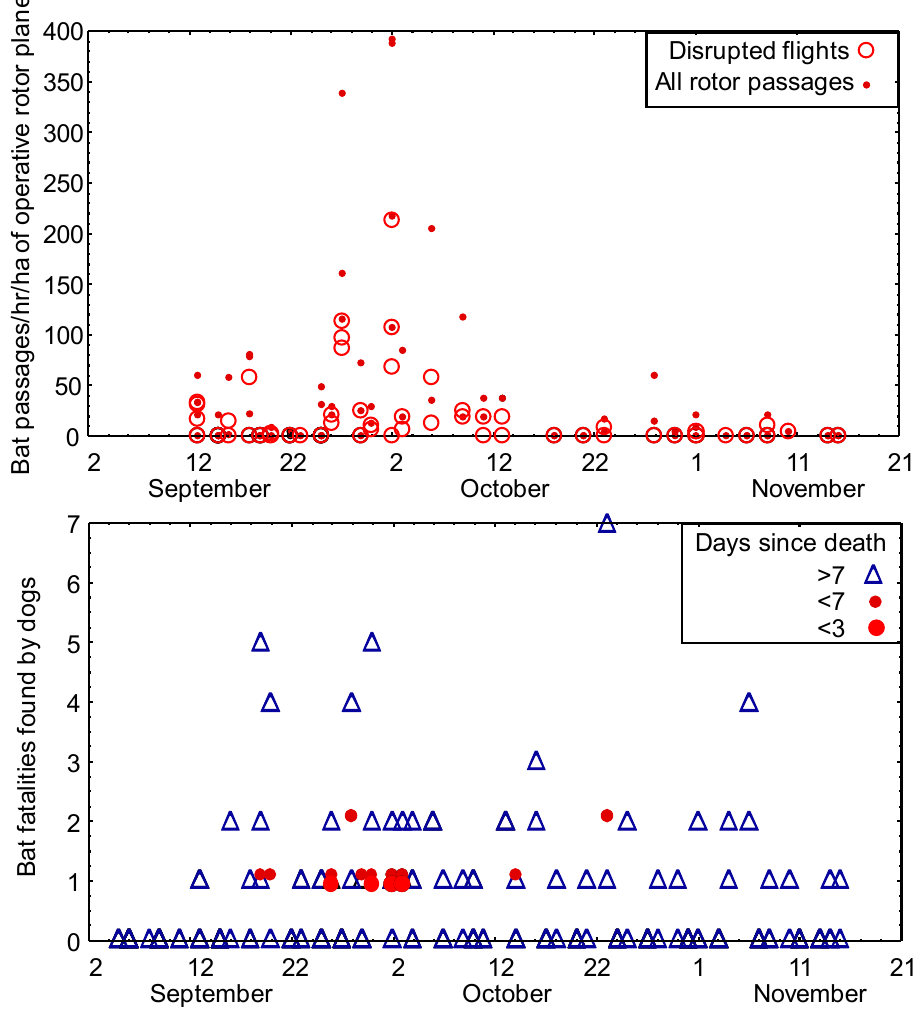
Figure 7. Bat passage rates through operative wind turbine rotors (top) corresponded with next-day fatalities of bats estimated to have died within a week (bottom) in 2017 in the Golden Hills and Buena Vista Wind Projects, Contra Costa and Alameda Counties, California